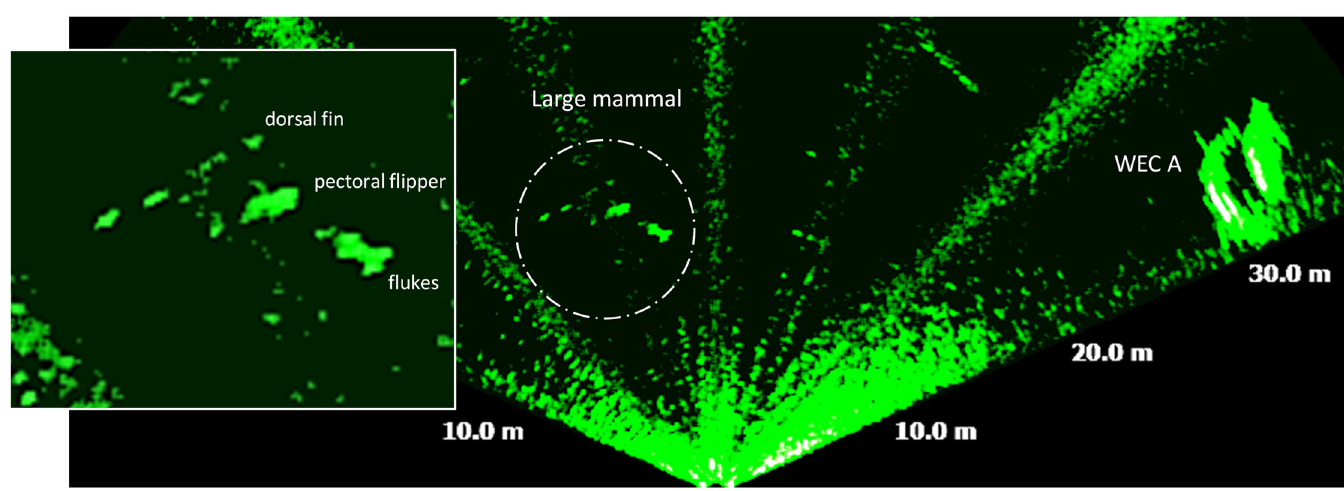
Fig 9. Acoustic image acquired on 28/08/16 at 19:39 UTC showing a large marine mammal (possible orca) located at 15 m of range, with 7 m of length, and a dorsal fin measuring 1.3 m of height.